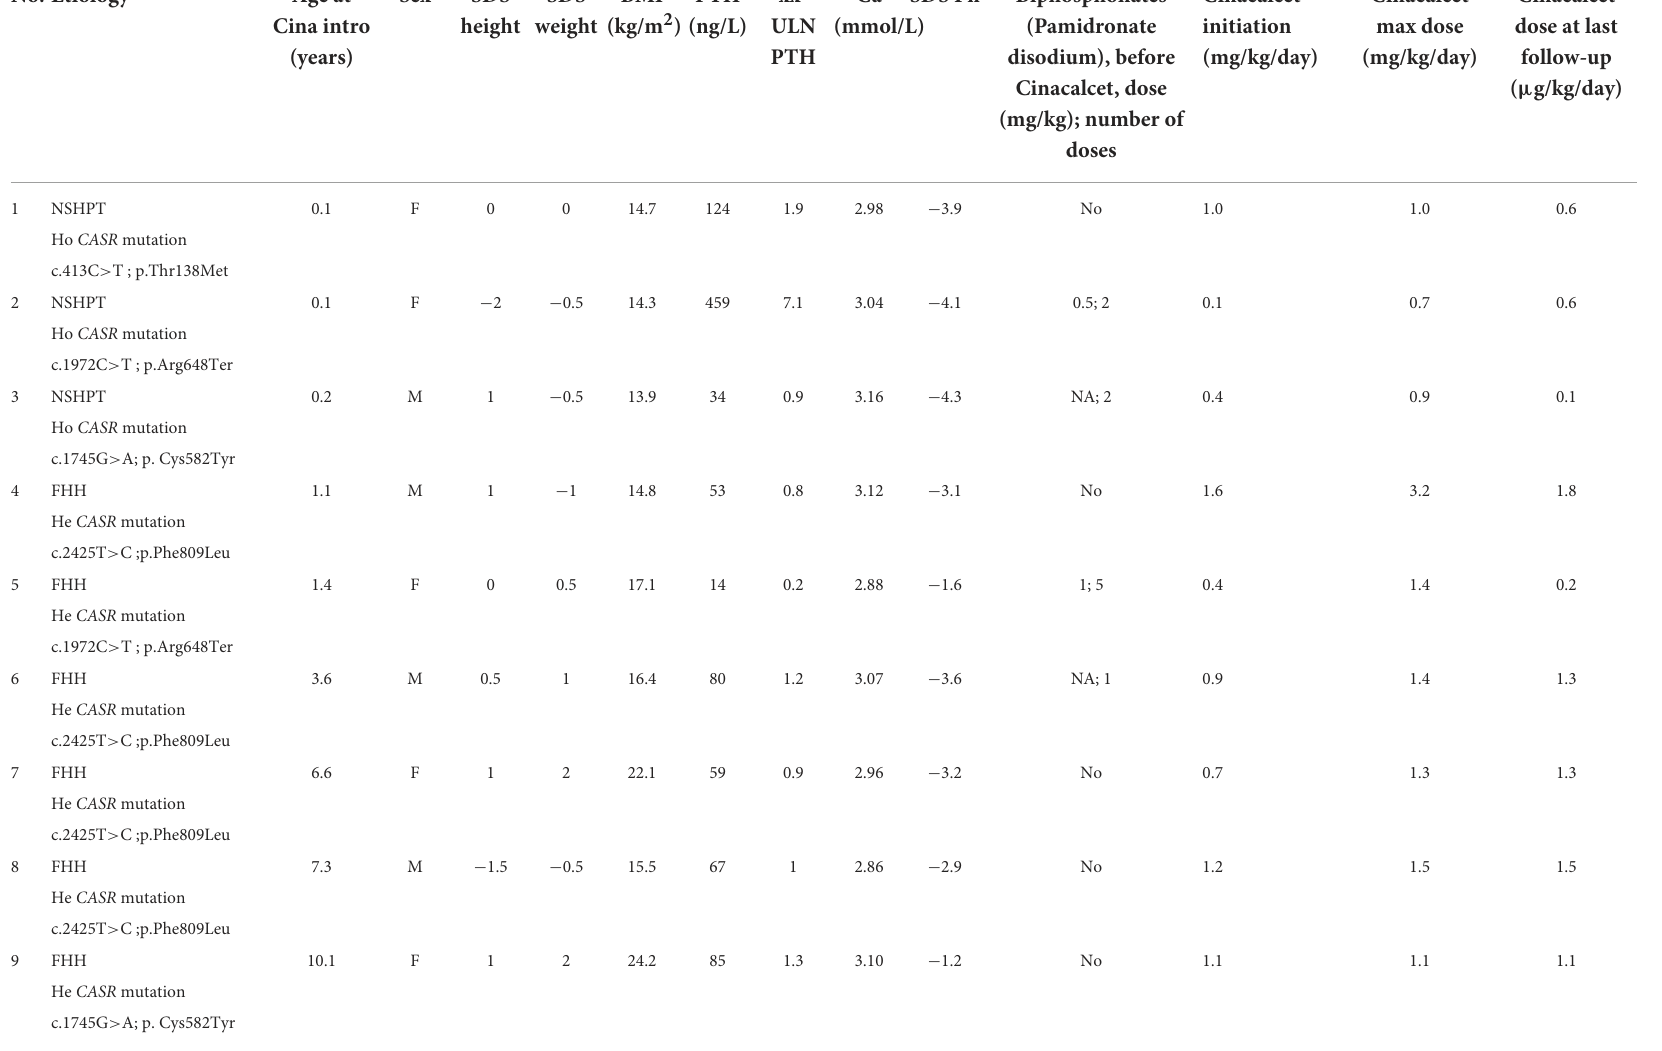
TABLE 2 Patient characteristics at Cinacalcet initiation and during